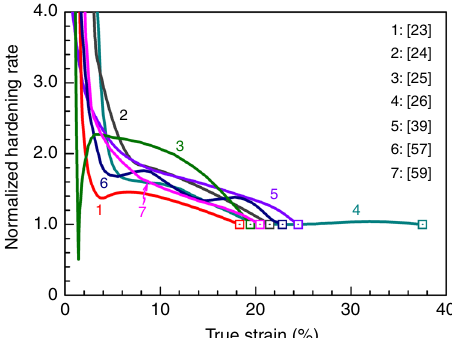
Fig. 5 Strain-hardening responses. Normalized strain-hardening rate ( Θ ¼ 1 σ (cid:2) ∂ σ ∂ ε ) versus true tensile strains in FCC HEAs. All alloys showed GPa-level yield strength. The Considère plastic instability point (when Θ descends to unity, marked using squares) is delayed to large tensile strain.